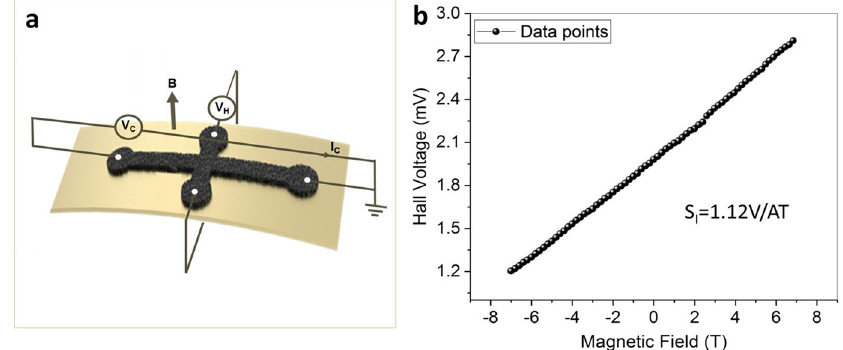
Fig. 2 Magneto-electro-mechanical characterization. a Four-terminal Hall-measurement con fi guration of the Hall sensor. b Hall voltage over external magnetic fi eld at a current of 100